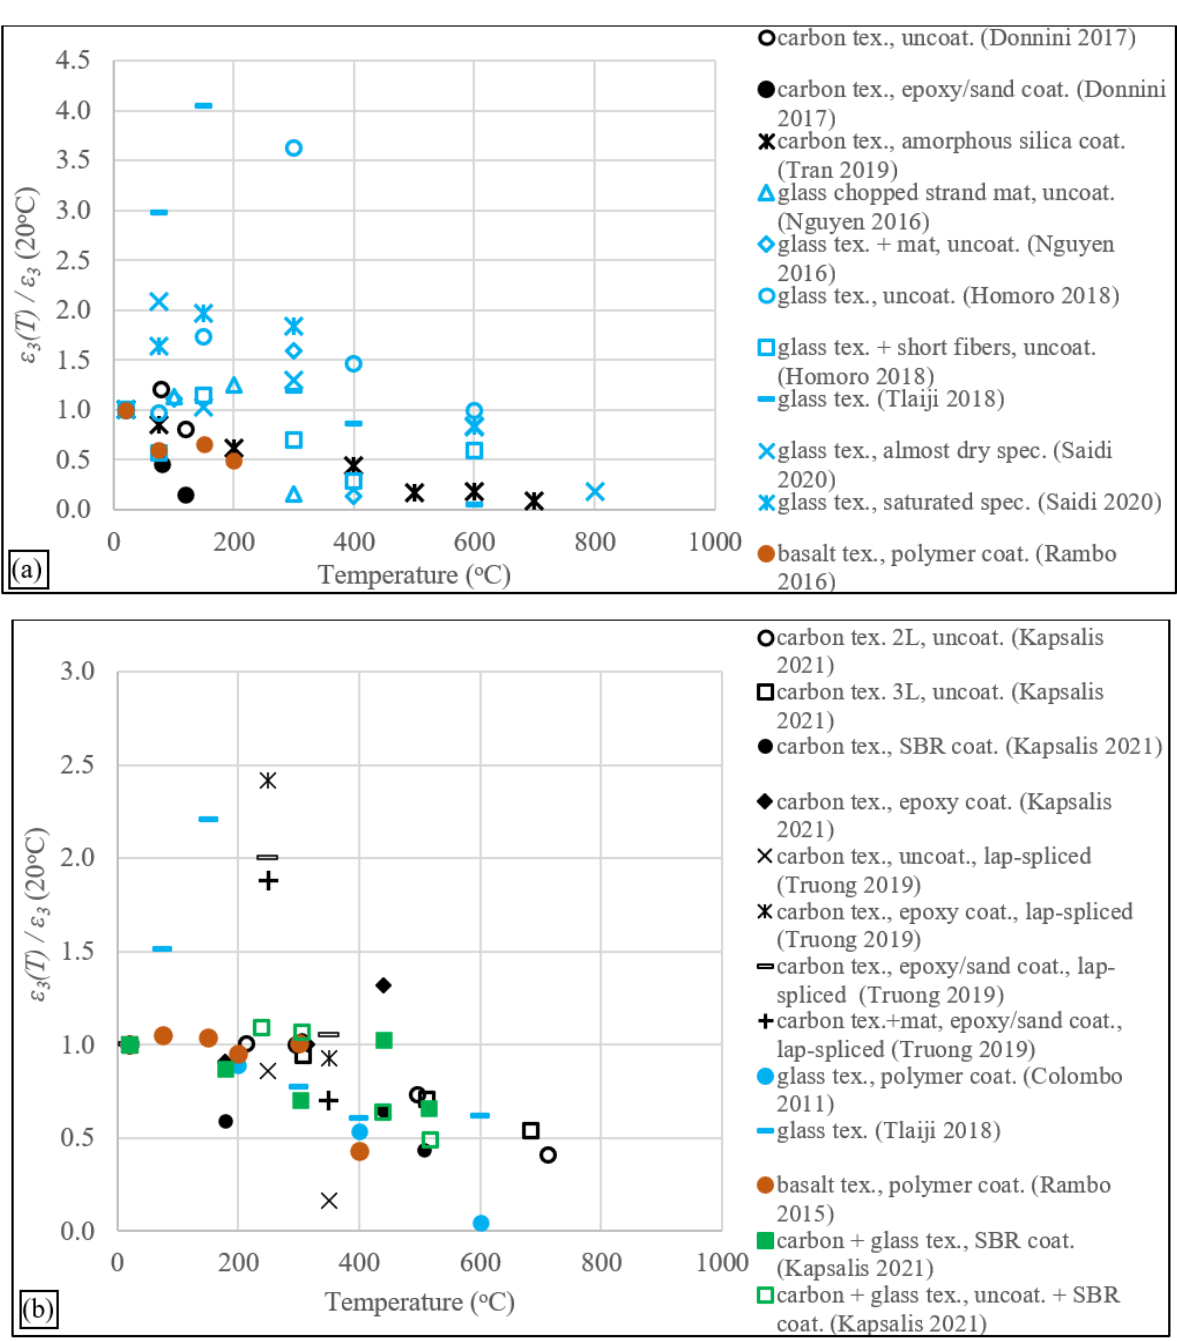
Figure 6. Post-cracking modulus ( E 3 ) versus exposure temperature for various TRC compositions; ( a ) specimens loaded while in heated conditions; ( b ) specimens tested after cooling down.